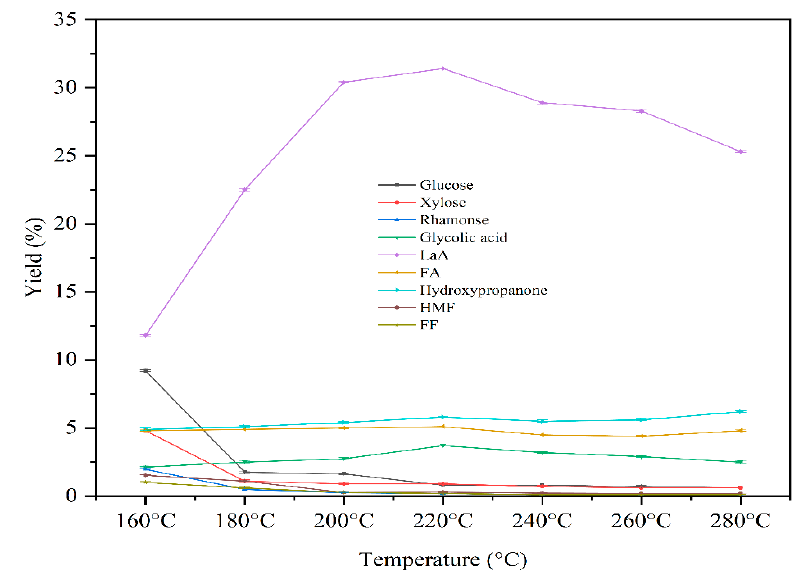
Figure 3. Yields of small molecular products from hydrothermal conversion of U. prolifera at different temperatures with YCl 3 . Reaction conditions: 1.0 g of U. prolifera , 100 mL water, 26 mmol/L YCl 3 if used, 2 MPa N 2 , 1 h.